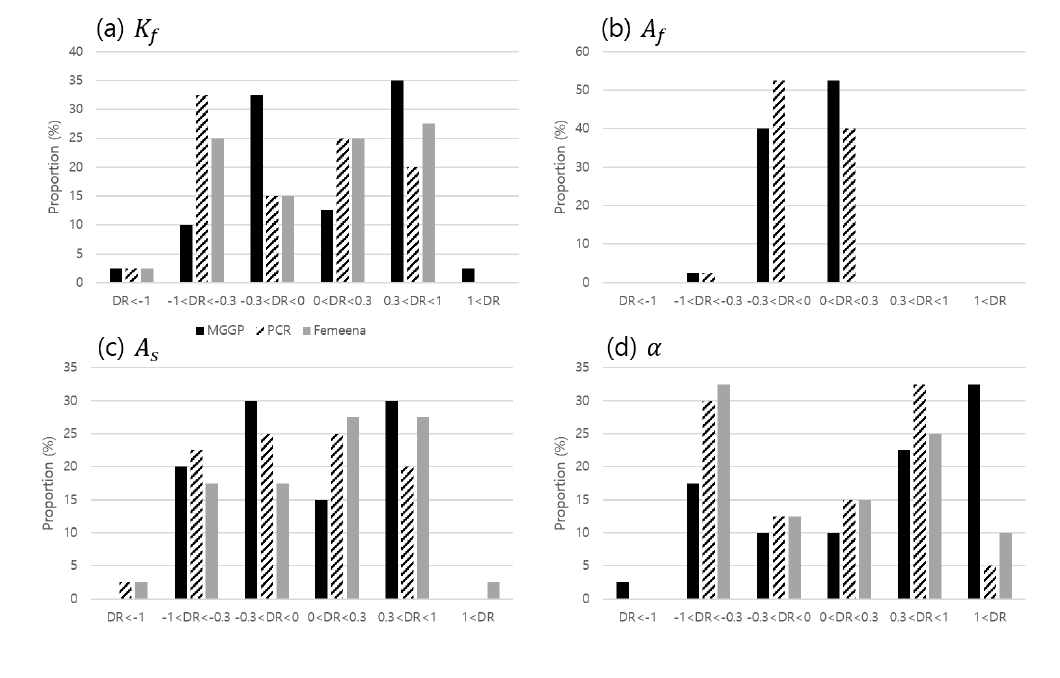
Figure 12. DR histograms of each empirical equations for TSM parameters for the test set; ( a ) K f . ( b ) A f . ( c ) A s . ( d ) α